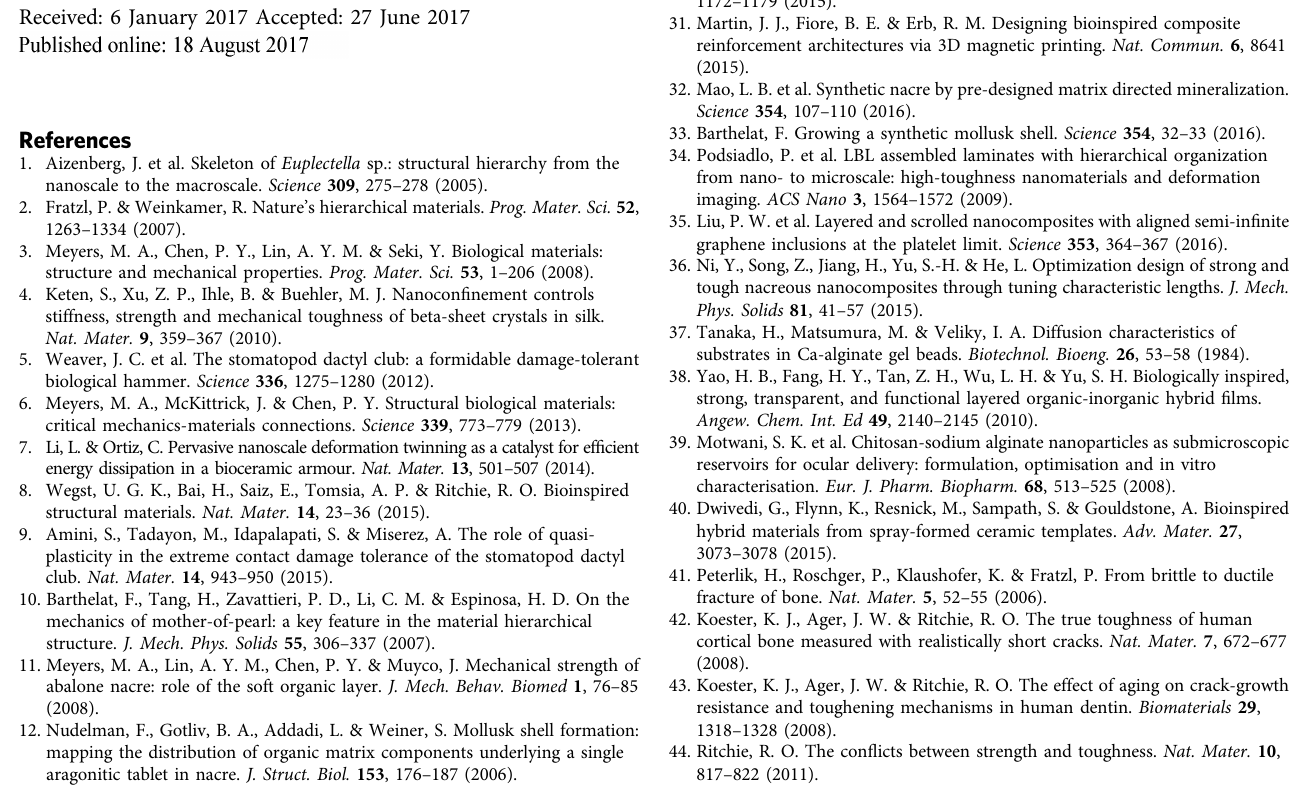
bending. The ends of top/bottom are fi xed and the loading are applied at the center of the bottom/top. We have chosen the parameters in the Abaqus model such that the fl exural stress-displacement curve in our numerical three-point bending test shown in Supplementary Fig. 12c can recover to the similar experimental three- point bending test shown in Fig. 2a (see the details in Supplementary